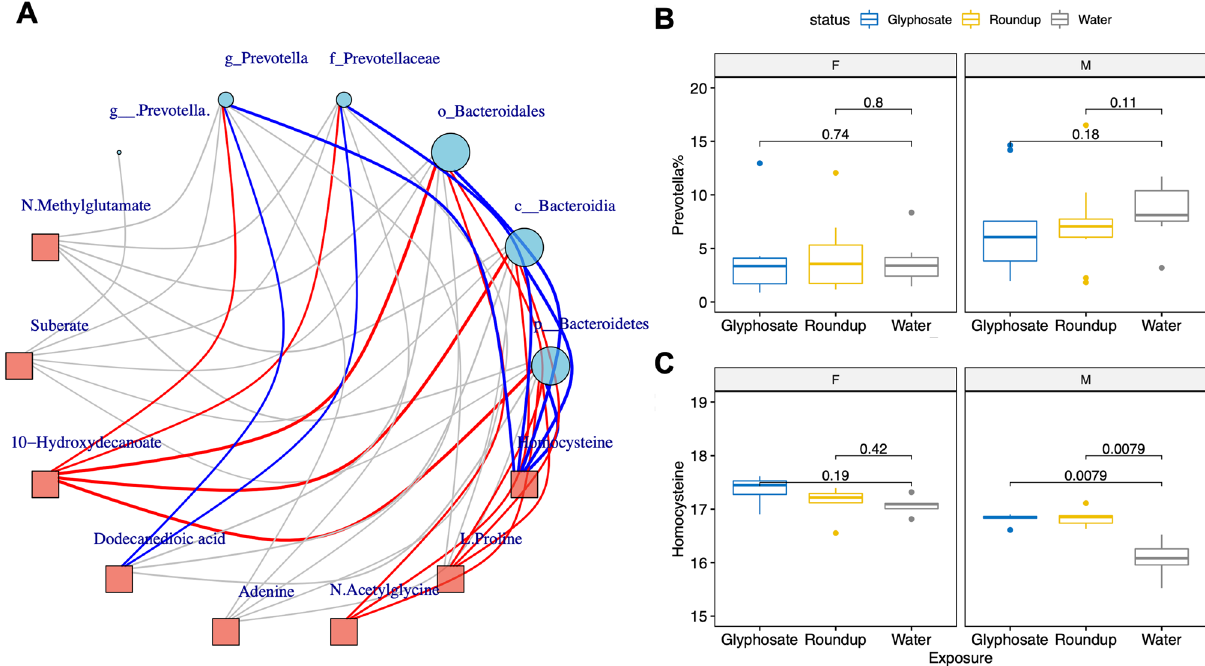
Figure 3. The urine homocysteine levels in pups are associated with sex and glyphosate or Roundup exposure and are strongly correlated with Prevotella abundance in gut microbiota. ( A ) Correlation network between exposure associated metabolic features and gut microbiota. Prevotella and its belonged Bacteroidetes phylum to Prevotellaceae family all show strong negative correlation with the urine homocysteine. The links with FDR adjusted p value < 0.05 are colored with red (positive correlation) and blue (negative correlation). ( B , C ) Boxplots showed that Prevotella abundances were lower in female pups than male pups. Prevotella was reduced in exposed male pups. In contrast, the female pups have higher homocysteine than the male pups and the homocysteine levels were significantly increased by exposure in male